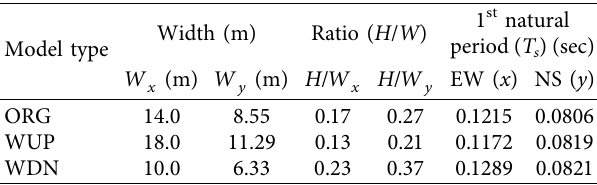
Figure 9: Regression result from the width data of 48 piloti buildings [32]. Table 5: Structural dimensional parameters and fundamental natural periods for parametric study